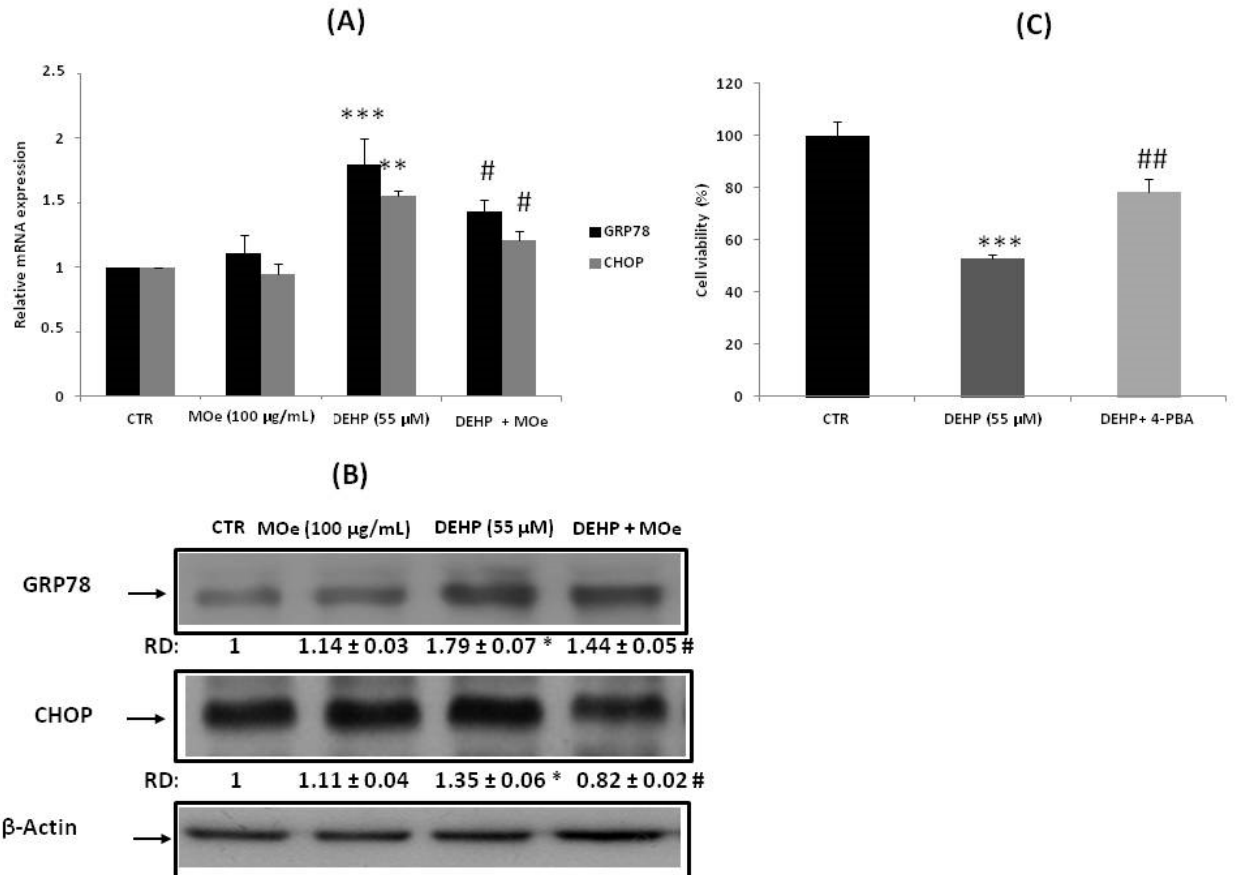
Figure 7. Effect of MOe on DEHP-induced endoplasmic reticulum (ER) stress. SH-SY5Y cells were pretreated with MOe (100 µ g/mL) for 2 h before DEHP treatment for 24 h (55 µ M). ( A ) The glucose-regulated protein 78 (GRP78) and CCAAT-enhancer-binding protein homologous protein (CHOP) mRNA levels were quantified by qRT-PCR and expressed as fold change over untreated controls. As a loading control, we have used β -actin. ( B ) GRP78 and CHOP protein levels were quantified by Western blot. RD: relative density as described in the Material and Methods Section. ( C ) Effect of 4-Phenylbutyric acid (4-PBA) pretreatment on SH-SY5Y cell viability. Values represent mean ± SD of three independent experiments. * p < 0.05, ** p < 0.01, *** p < 0.001 vs. control, and # p < 0.05, ## p < 0.01 vs. DEHP alone.